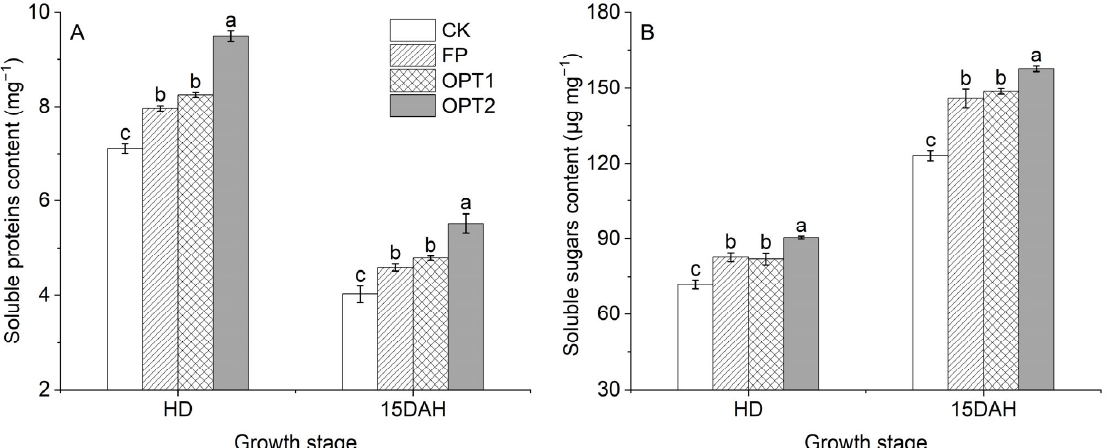
Figure 7. Soluble sugars ( A ) and soluble proteins ( B ) under four management systems at HD and 15DAH. Means followed by the same letter do not significantly differ (LSD, p < 0.05). 3.8. The Activities of POD, CAT, T-SOD, and APX Enzymes and the Content of MDA At HD, the POD and CAT enzyme activities showed a consistent trend across treat- ments, with OPT2 > OPT1 > FP > CK (Figure 8), but the T-SOD enzyme activities were not significantly different between FP and OPT1. Among them, the POD and CAT enzyme activities of OPT2 were 17% and 21% higher than OPT1, and 38% and 49% higher than FP, respectively.